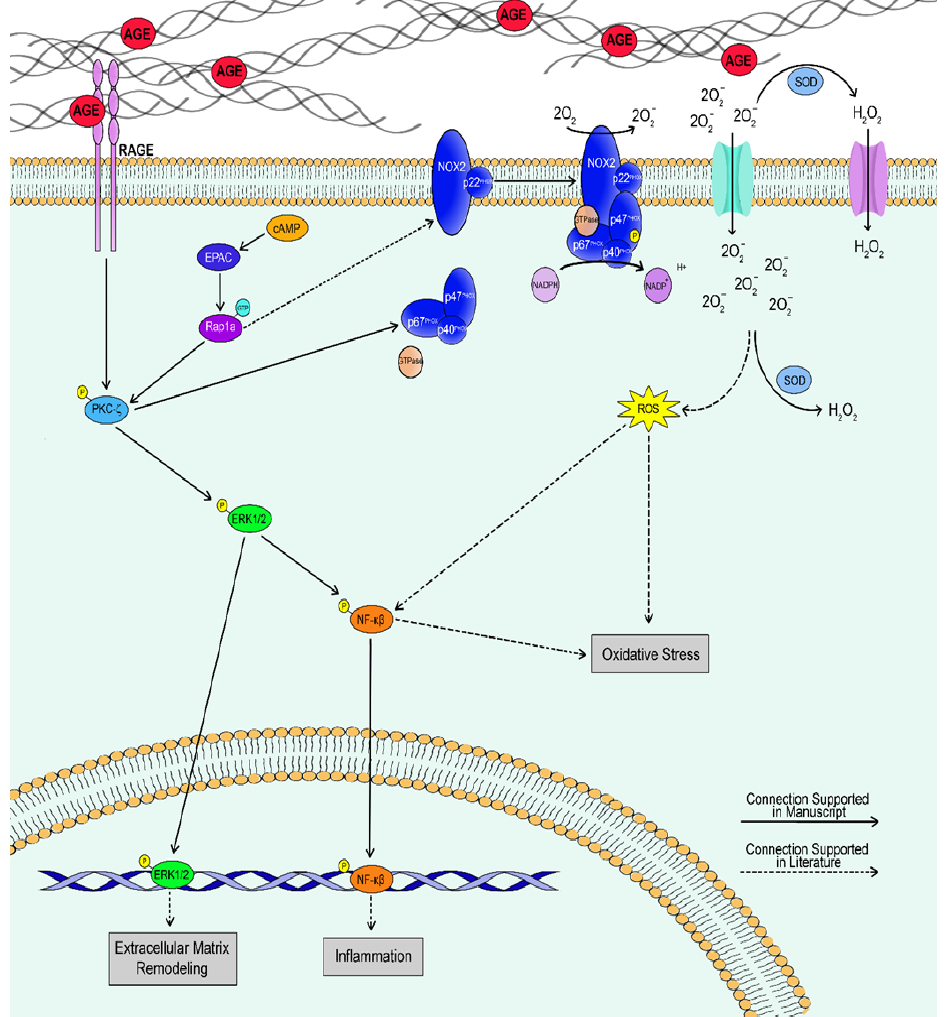
Figure 10. Diagram depicting the relationship between Rap1a and the AGE/RAGE signaling cascade. Potential interactions between proteins are shown with arrows with directionality of impact being denoted with arrow orientation. Solid line arrows indicate connections that are supported by evidence presented within this manuscript, while dash line arrows show connections that are supported within the literature.